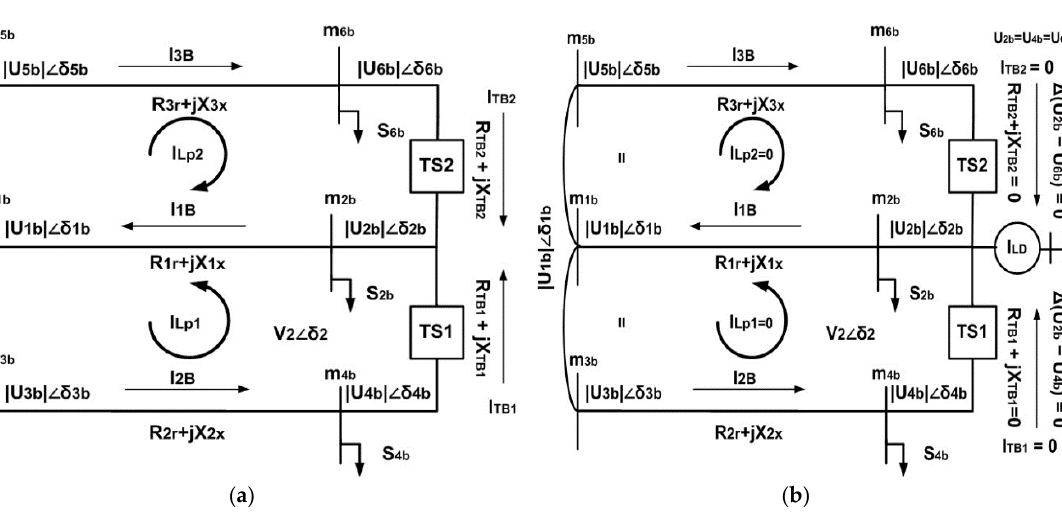
Figure 4. ( a ) Electrical equivalent model for actual mesh distribution system (MDS) containing loop currents; ( b ) Electrical equivalent model for an MDS aiming at loss minimization with respective loss minimalize condition (LMC).